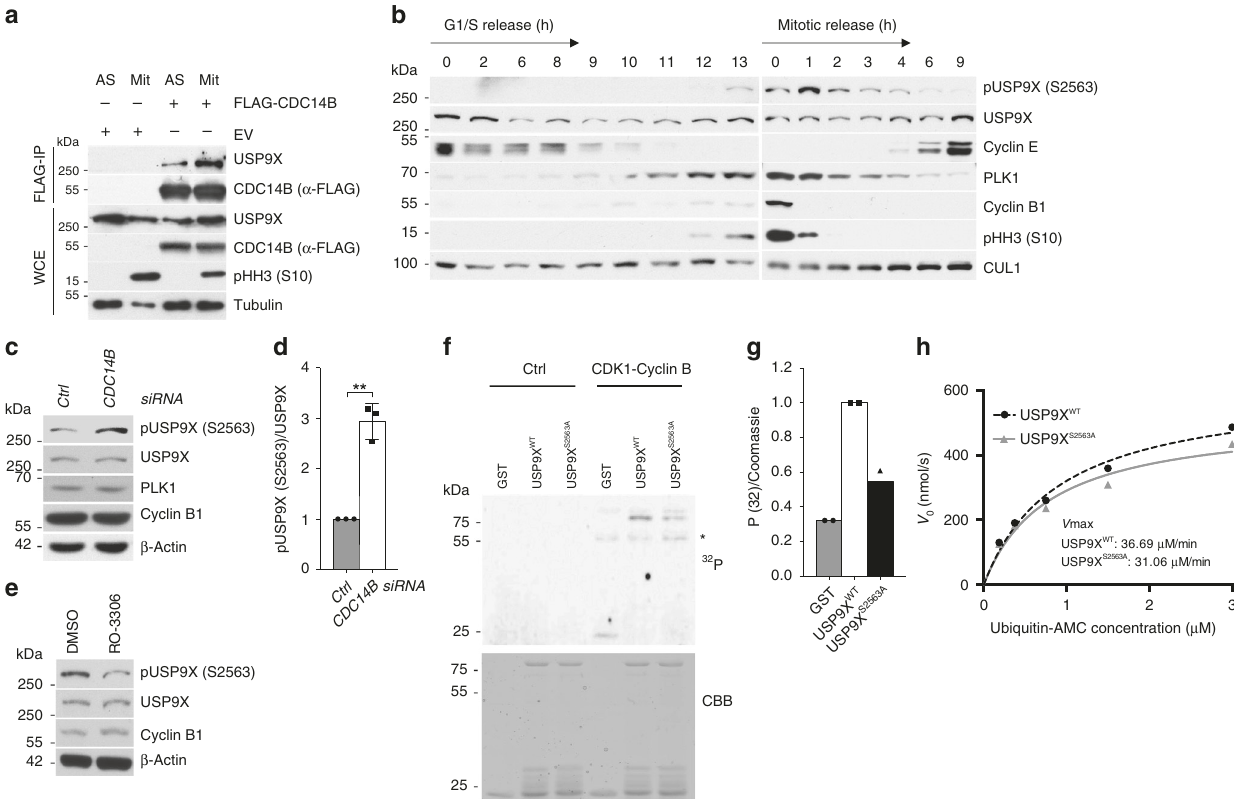
Fig. 1 CDC14B and CDK1 regulate phosphorylation of USP9X at serine 2563 in mitosis. a Co-immunoprecipitation of FLAG-tagged CDC14B with endogenous USP9X from HEK 293T cells that were either left untreated or arrested in mitosis using nocodazole (EV = expression vector). Immunocomplexes and respective WCE were probed with antibodies to the indicated proteins. b Immunoblot analysis of U2OS cells that were either synchronized in G1/S phase using a double thymidine block (left panel), or in mitosis using sequential thymidine and nocodazole treatment (right panel). Cells were then released into the cell cycle and collected at the indicated time points. c Immunoblot analysis of U2OS cells that were treated with siRNA directed against CDC14B and synchronized in mitosis as described above. Mitotic shake-off was performed and samples were analyzed by western blot with the indicated antibodies. d Quanti fi cation of n = 3 biologically independent experiments conducted as described in c . Ratio paired t -test was applied with ** p = 0.0045. e Immunoblot analysis of mitotic U2OS cells after synchronization with thymidine and nocodazole. Mitotic cells were shaken off and kept in nocodazole-containing medium during treatment with either the CDK1 inhibitor RO-3306 or DMSO for 0.5 h. f In vitro kinase assay with C-terminal truncates of USP9X (aa 2165 – 2570), either the USP9X wild-type form (USP9X WT ) or a USP9X form with a serine to alanine mutation on position 2563 (USP9X S2563A ), that were puri fi ed from Escherichia coli and exposed to recombinant active CDK1-Cyclin B in the presence of radioactive 32 P-ATP (CBB, Coomassie Brilliant Blue), *Cyclin B. g Quanti fi cation of two independent experiments conducted as described in f . 32 P signals are normalized to the respective Coomassie signal. Mean is displayed from n = 2 biologically independent experiments. h Enzyme kinetics of USP9X WT and USP9X S2563A proteins puri fi ed from mitotic HEK 293T cells were measured at different Ubiquitin-AMC concentrations. The resulting values for K M of USP9X WT or USP9X S2563A were 0.9090 or 0.7835 µ M, respectively, and for V max 36.69 or 31.06 µ M/min, respectively. The values indicated are from n = 1 experiment. Throughout this fi gure means and standard deviations as error bars are